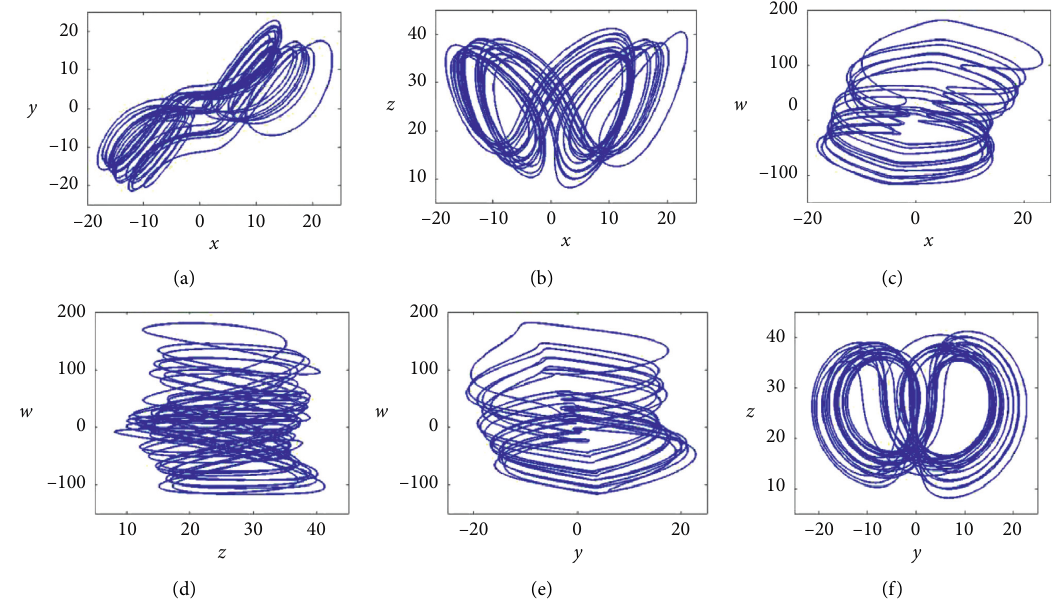
Figure 1: Hyperchaotic attractors in (a) x - y plane, (b) x - z plane, (c) x - w plane, (d) z - w plane, (e) y - w plane, and (f) y - z plane.